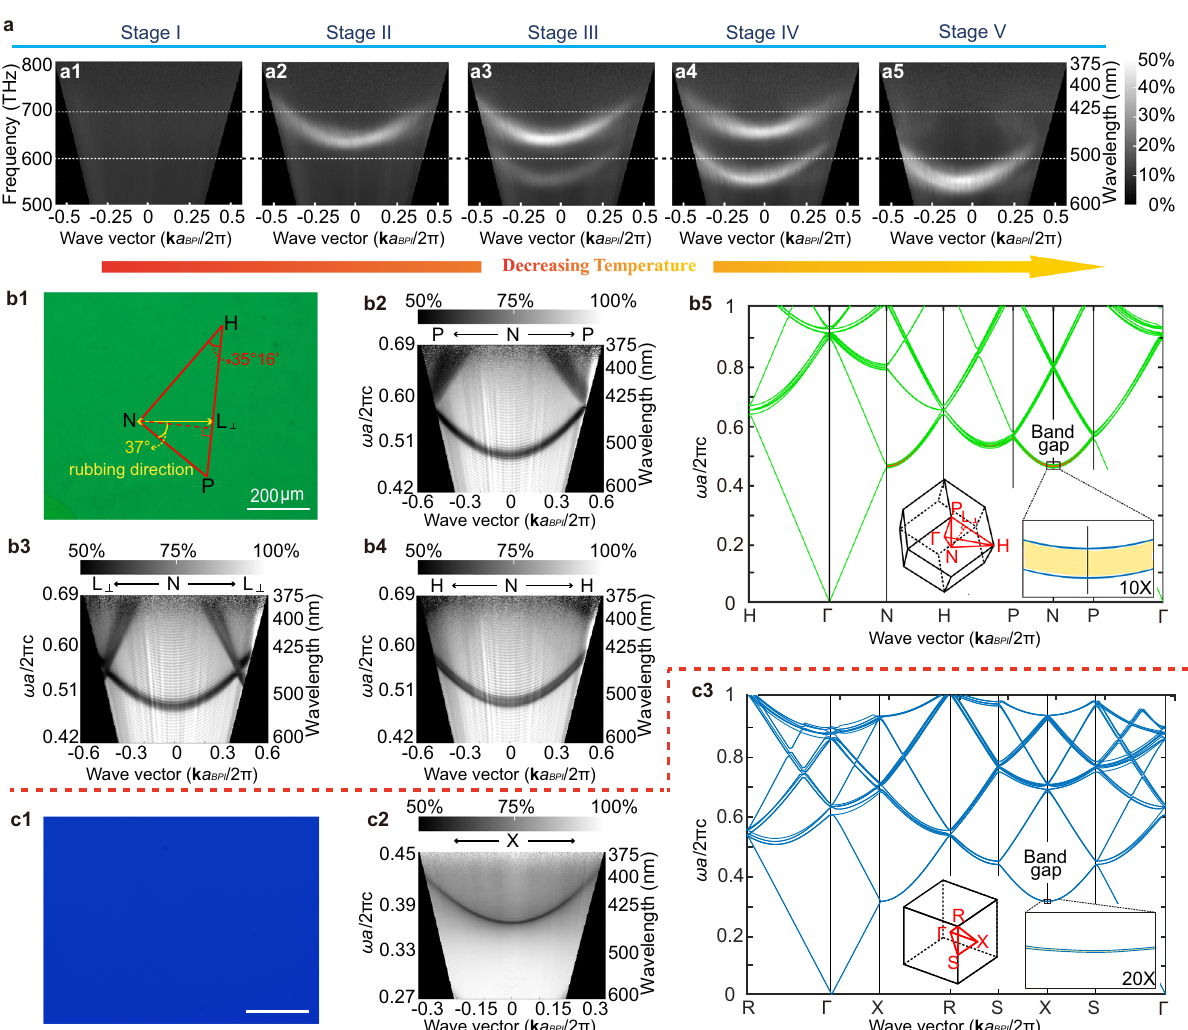
Fig. 4 Relationships of lattice orientation during DLPT characterized by ARM and simulated band structures. a In situ observation of micro-re fl ectance streaks of polydomain BPLCs during the phase-transition process from Stages I to V. The wave vectors are normalized by k a , where a = 254.48 nm is the 2 π lattice constant of BPI. The color scale indicates the re fl ection of the measured area. The color scale besides a 5 is also available for a 1 – a 4 . b 1 The typical texture of monodomain BPI {110} (with λ c = 520 nm at normal incidence after polymerization) obtained using POM. The red line and yellow arrow represent the detection directions and rubbing direction, respectively. b 2 , b 3 , and b 4 Contour plots of measured transmittance of BPI in the N → P , N → L ⊥ and N → H directions, respectively. b 5 Calculated photonic band structure on the edges of irreducible BZ of BCC BPI. c 1 The typical texture of monodomain BPII {100 ) (with λ c = 463 nm at normal incidence after polymerization) obtained using POM. c 2 Contour plots of measured transmittance of BPII. c 3 Calculated photonic band structure on the edges of the irreducible BZ of BPII. Inserts in b 5 , c 3 show BZ of BPI or BPII with symmetry points and opening of the local bandgap. Three closely spaced pseudogaps are observed along the Γ N ([110]), Γ P ([200]), and Γ H ([210]) directions of BPI and the Γ X ([100]), Γ S ([110]) and Γ R ([111]) directions of BPII. The BPI covered by BPII in the BPIII/BPII/BPI core-shell con fi gurations is con fi rmed through in situ ARM, and the topotaxial relationship between BPI and BPII in Stage III is found to be {100} BPII //{110} BPI . Signi fi cantly, a rotation of the parent phase (BPII) occurs during cooling from Stage III to Stage IV, resulting in BPI {211} //BPII {110} and an ~{100} BPII //{110} BPI in Stage IV. In addition, the azimuthal angle between the [100] direction and rubbing direction is determined by angle-resolved re fl ectance microspectroscopy through the [110]